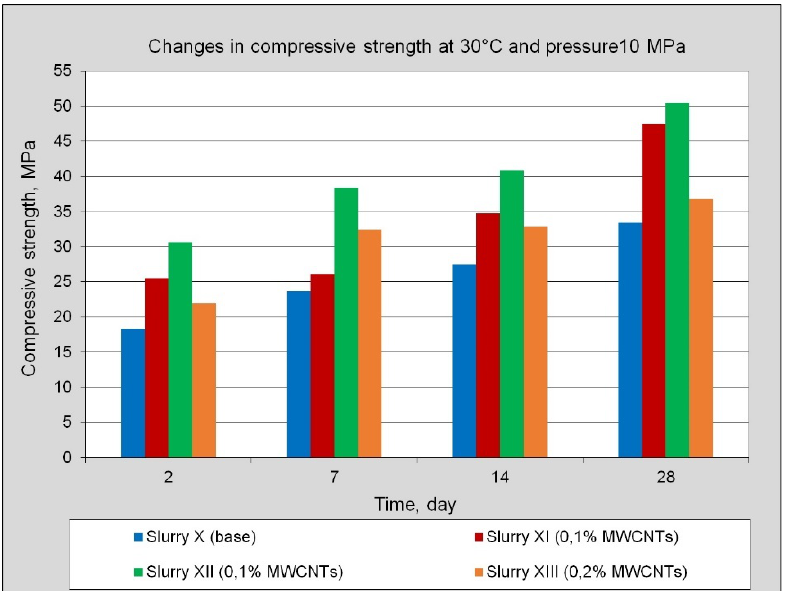
Figure 10. Changes in the compressive strength of samples X, XI, XII, XIII after 2, 7, 14, and 28 days of hydration.